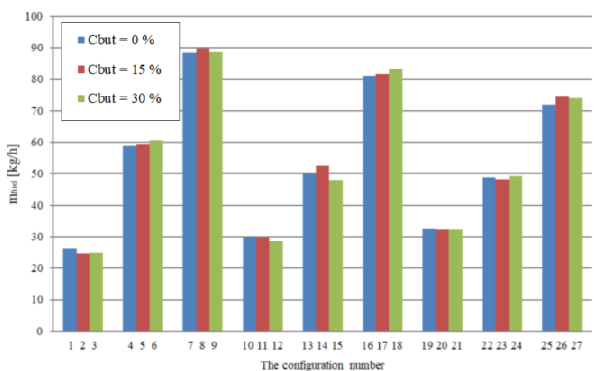
Fig. 2. Comparison of the fuel consumption for the engine fed with blend n-butanol fuel and MDF